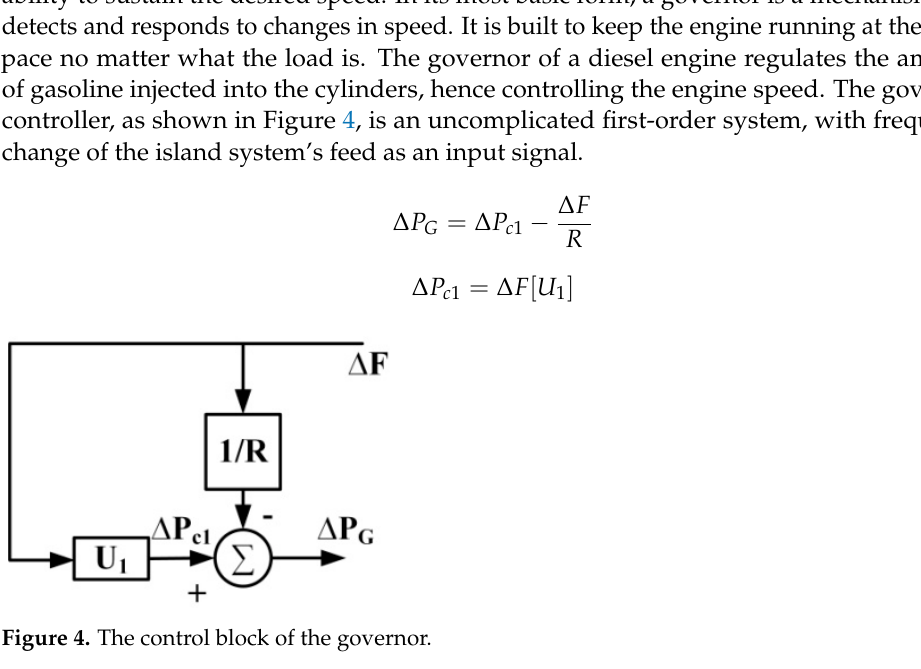
Figure 3. Block diagram of the Island Hybrid Power System.